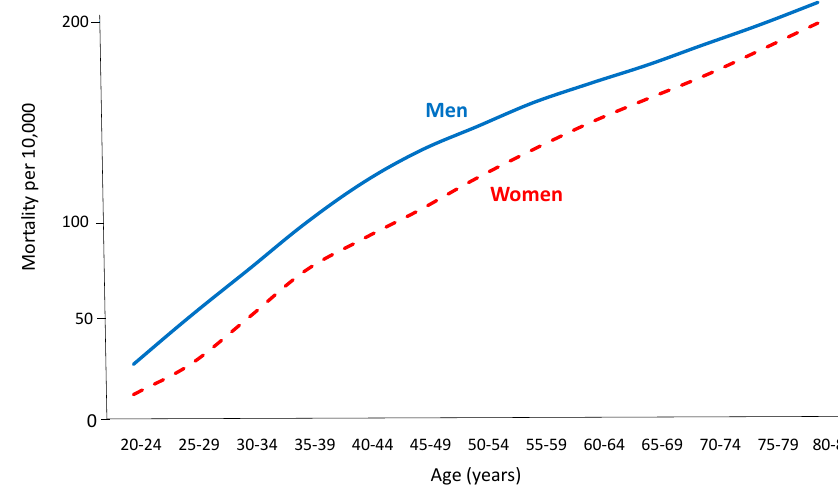
Figure 1. Mortality rates for coronary heart disease in the USA in 2000, by sex; Global Burden of Disease study data.